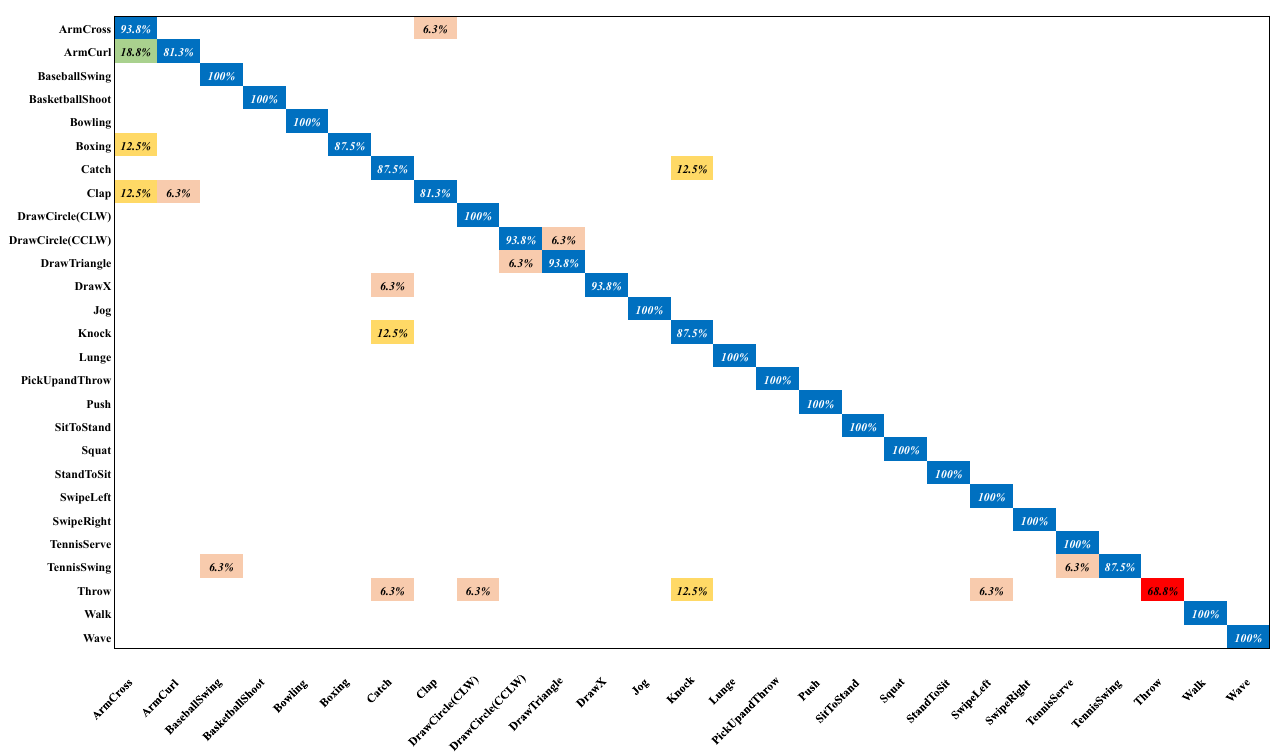
Figure 10. Confusion chart of UTD-MHAD dataset (best results with SSIM, k = 24).